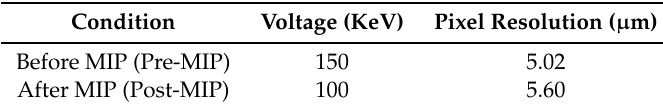
Table 2. XCT parameters used before and after MIP